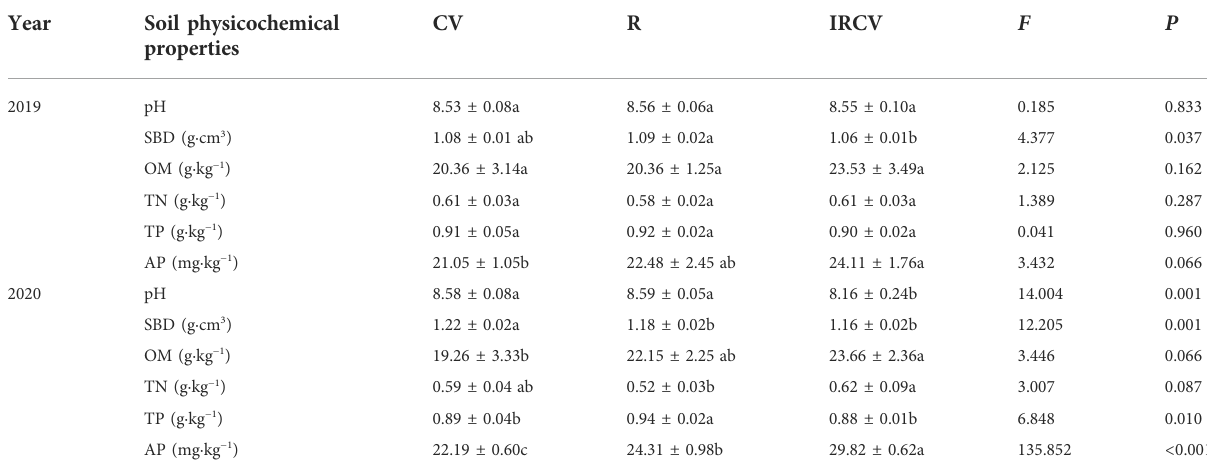
TABLE 1 Soil physicochemical properties.